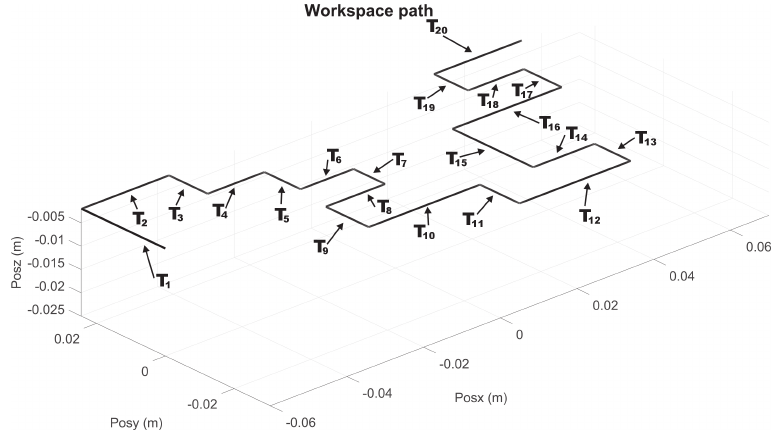
Figure 13. Composite task from T i transects for left haptic device of exercise 2 (MCM).